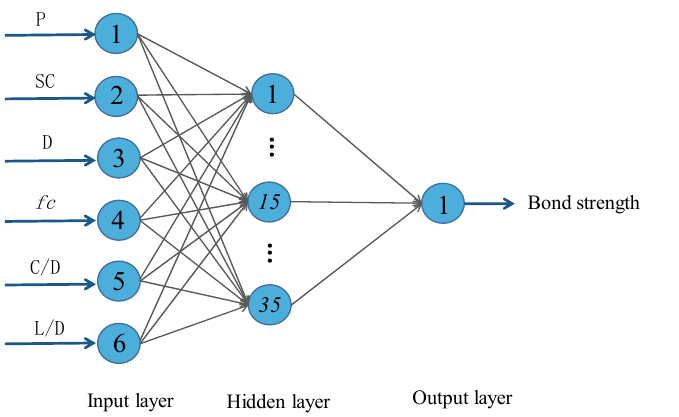
Figure 3. ELM model network structure.